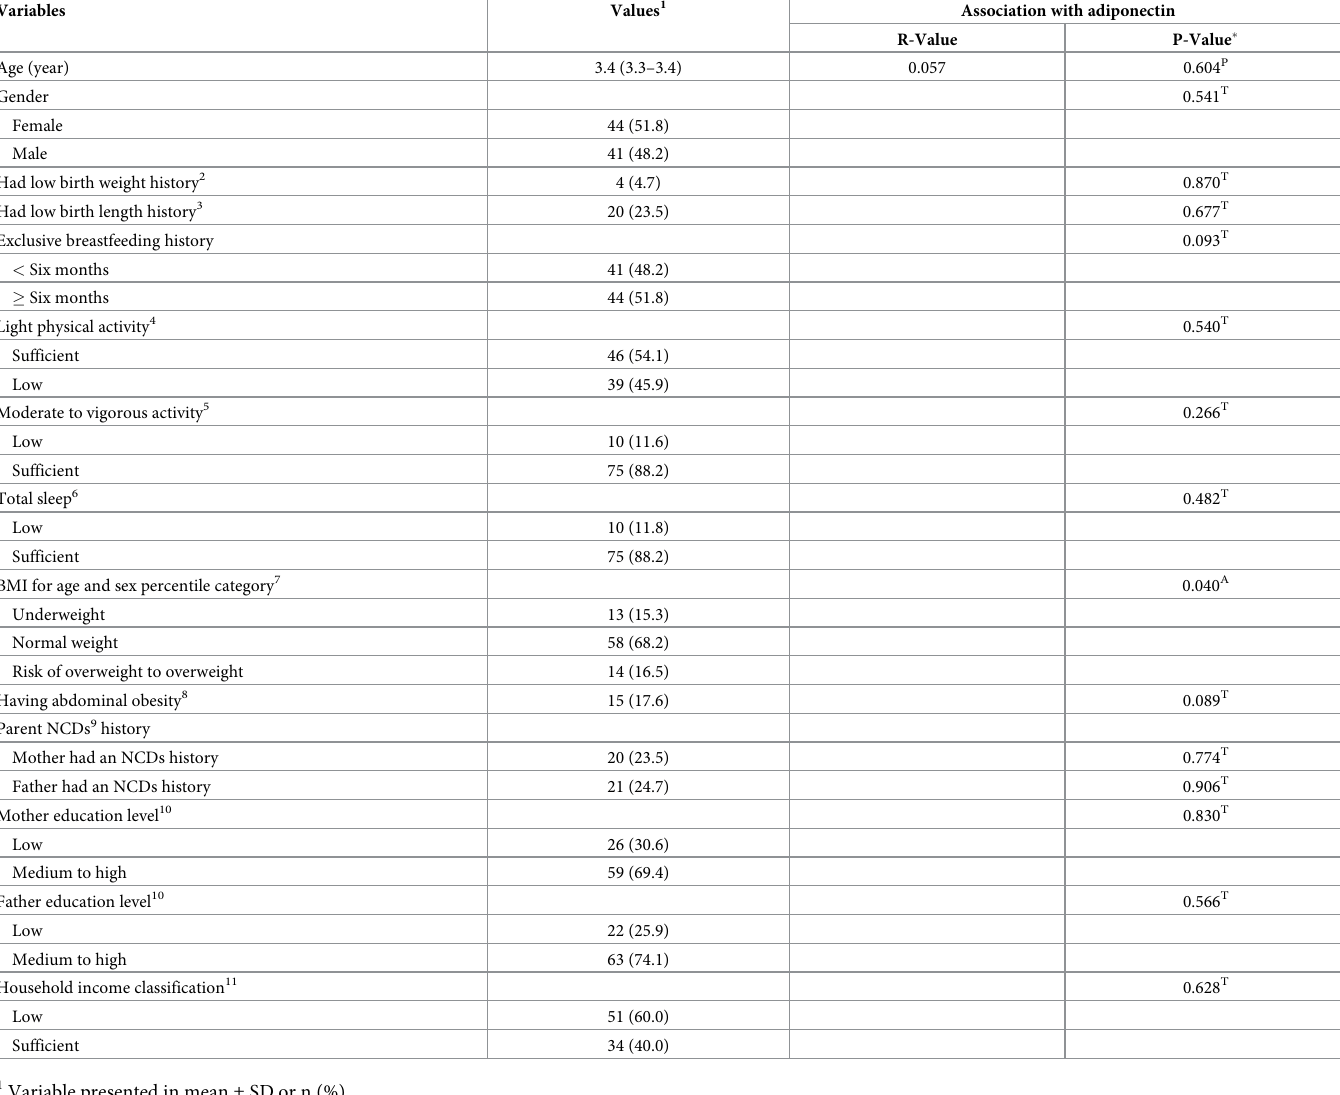
Table 1. General characteristics of preschool-age children in the urban area of Jakarta and its association with serum adiponectin (n = 85).